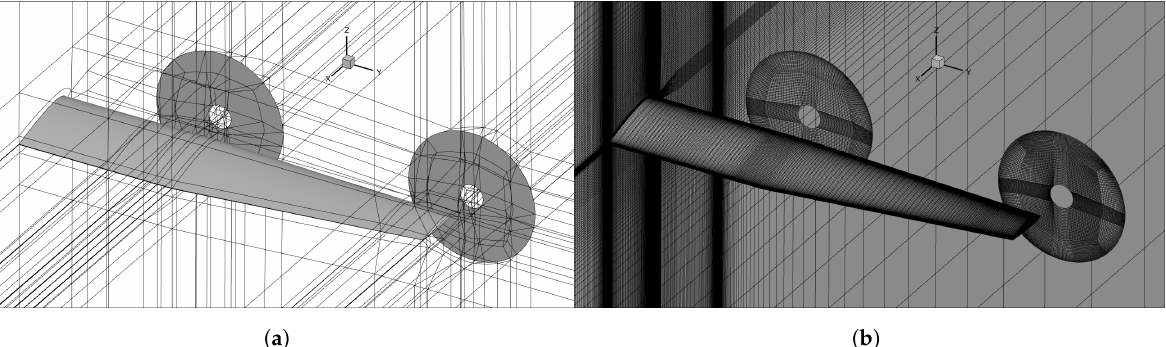
Figure 3. Computational grid used in FVM computations: ( a ) blocking topology; ( b ) wing surface and symmetry plane